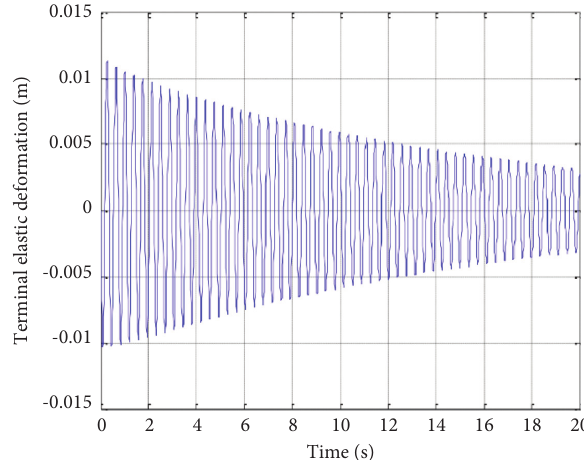
Figure 5: Tip deflection of the flexible manipulator with PD